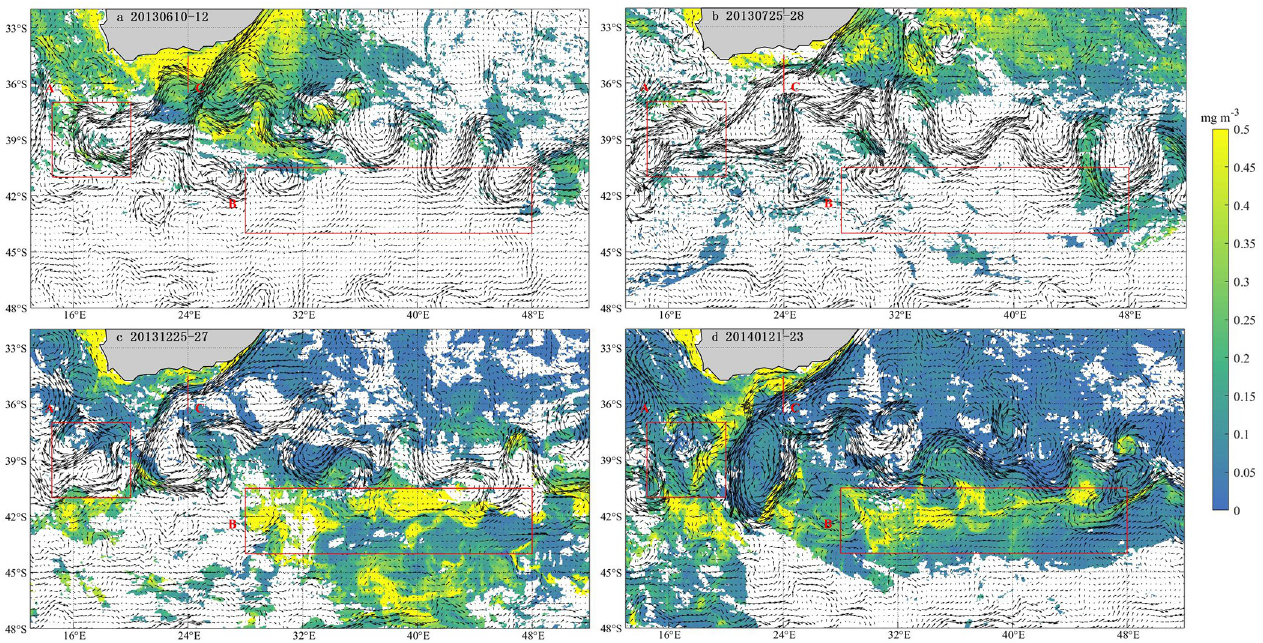
Fig 2. The 3-day average of the flow field and Chl-a. (a) 2013.6.10–12, (b) 2013.7.25–27, (c) 2013.12.25–17, (d) 2014.1.21–23. Color bars denote Chl-a concentration (unit: mg � m -3 ) and black arrows indicate the direction of the Agulhas